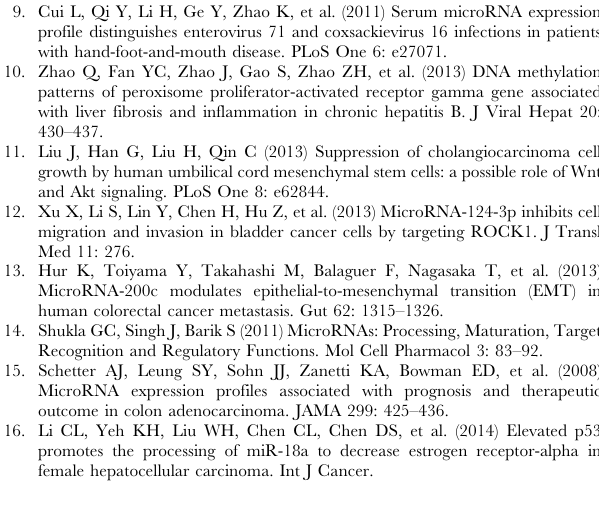
Figure S2 Wound healing assay: miR-374a/545 may increase the migration of HCC in vitro. The cells in six-well plate were scratched with pipette tip, incubated at 37 u C, 5% CO 2 for 24 hours after being transfected by miroRNA mimics or inhibitor, then monitored by photographing for wounding. Result